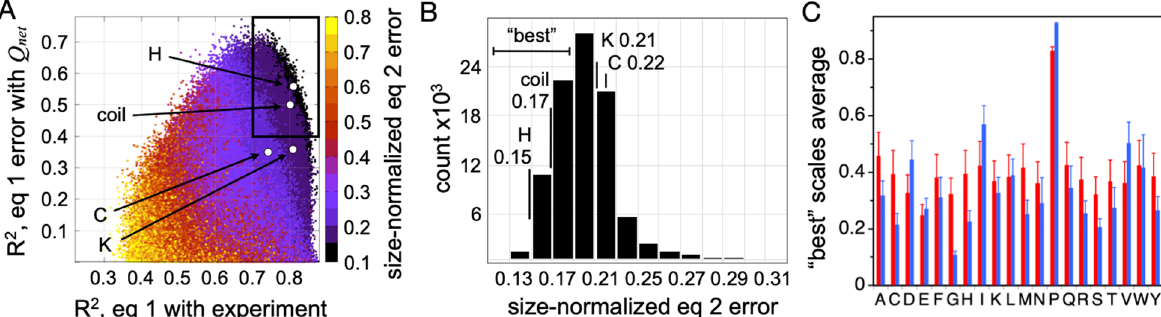
Figure 6. Using experimental R h from IDPs to determine amino acid-specific intrinsic PPII propensities. ( A ) Ability of experimental PPII propensity scales (from Table 1) to describe the sequence dependence on IDP R h compared to 10 6 random PPII propensity scales. Missing amino acids from scales measured by Kallenbach (column 3, Table 1) and Creamer (column 2, Table 1) were given the scale average (bottom value, Table 1). Compared as well is the result from using a coil library scale (Table 3). In panels A and B, results from using scales from Hilser and coworkers, Kallenbach and coworkers, Creamer and coworkers, and the coil library are labeled “H”, “K”, “C”, and “coil”, respectively. ( B ) Histogram of error distribution in the boxed region of panel A. Small errors are better. ( C ) Average scale value calculated for each of the 20 common amino acids using the “best” performing random PPII propensity scales (red bars). Average scale value using the “best” performing random scales that also maintain correct rank order for the nonpolar amino acids (blue bars), yielding an experimental PPII propensity scale based on IDPs. Error bars report standard